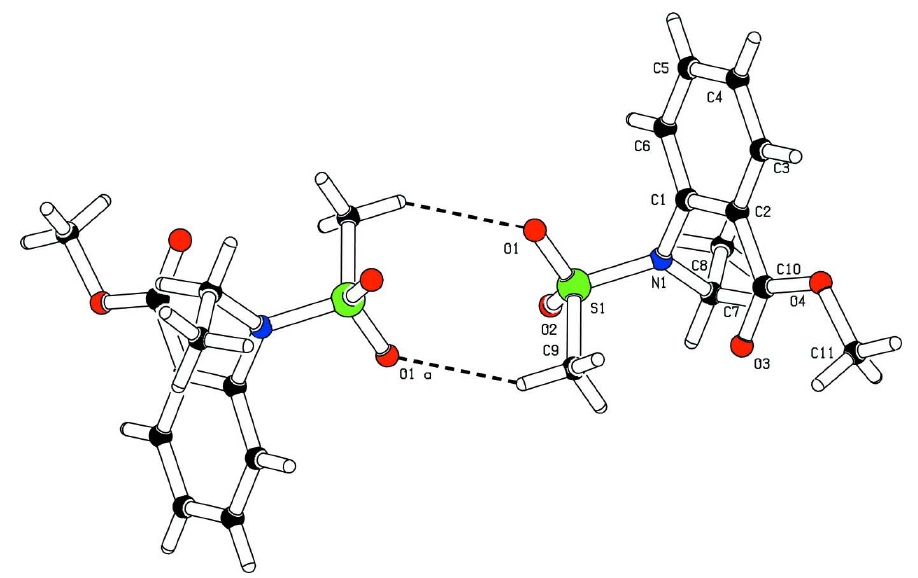
Figure 2 A partial packing diagram of (I). Hydrogen bonds are shown as dashed lines [symmetry code: ( a ) - x , - y , - z ]. Methyl 2-( N